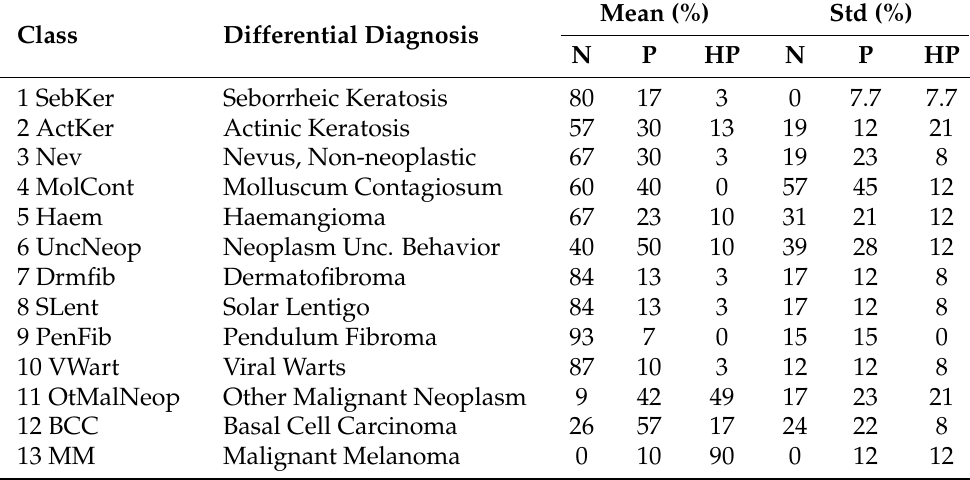
Table 2. Knowledge map distribution per differential